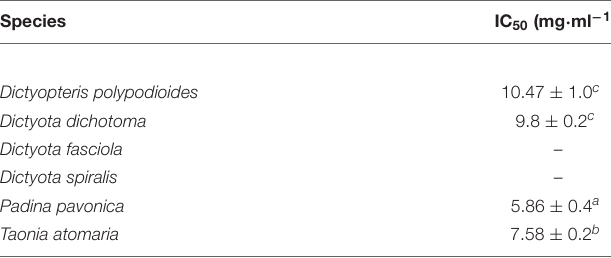
TABLE 2 | DPPH antiradical-scavenging capacity (IC 50 ) of Dictyotales samples.